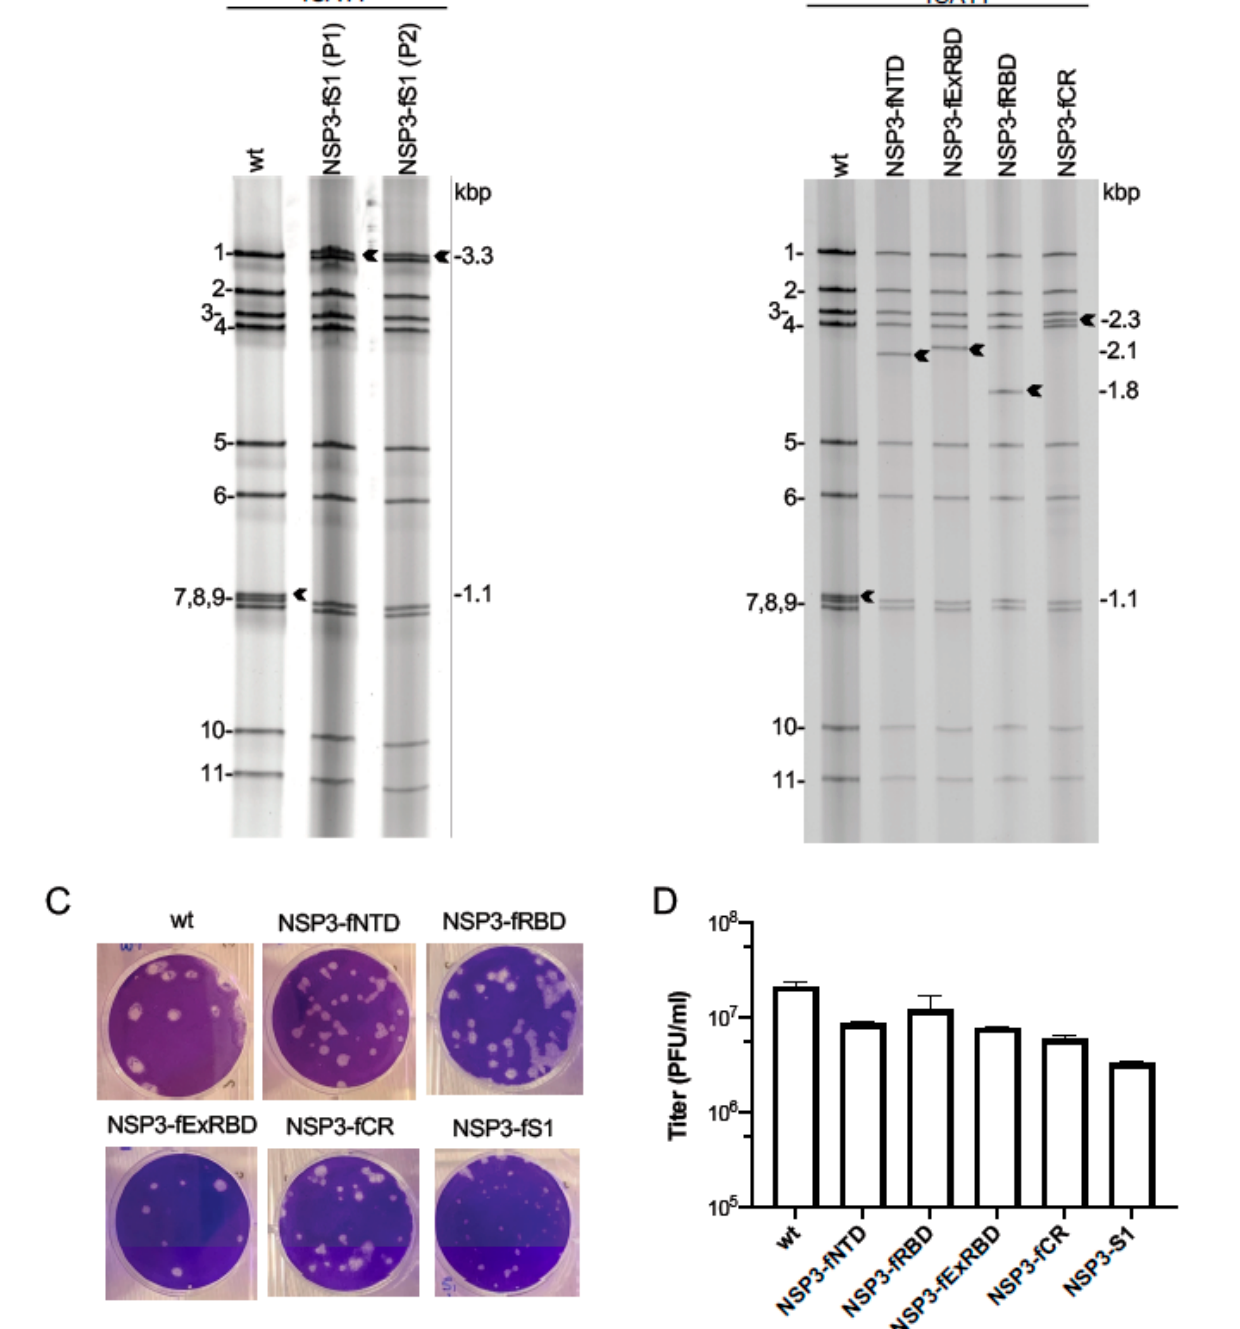
Figure 3. Properties of rSA11/NSP3-CoV2/S viruses expressing regions of the SARS-CoV-2 S protein. ( A , B ) dsRNA was recovered from MA104 cells infected with plaque-purified rSA11 isolates, resolved by gel electrophoresis, and detected by ethidium-bromide staining. RNA segments of rSA11/wt are labeled 1 to 11. Sizes (kbp) of segment 7 RNAs (black arrows) of rSA11 isolates are indicated. Double-stranded RNA of rSA11/NSP3-fS1 serially passaged twice (P1 and P2) in MA104 cells is shown in ( A ). ( C ) Plaque assays were performed using MA104 cells and detected by crystal-violet staining. ( D ) Titers reached by rSA11 isolates were determined by plaque assay. Bars indicate standard deviations calculated from three separate